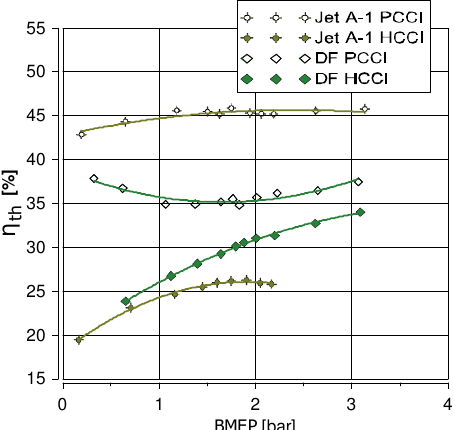
Fig. 12. Engine thermal efficiency for four modes of fuelling